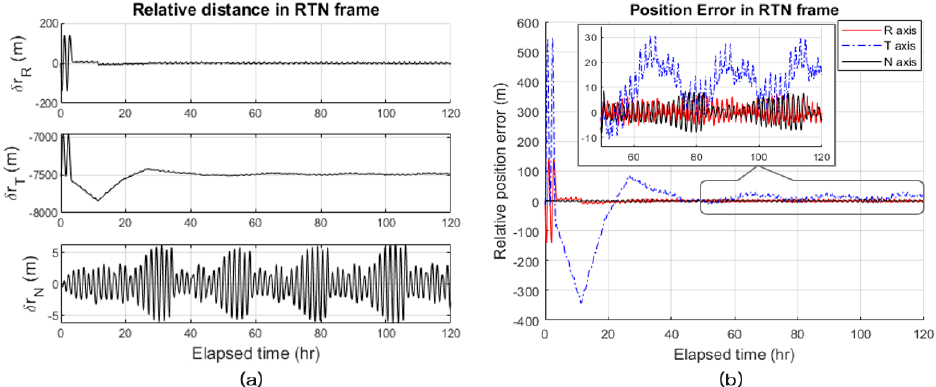
Figure 6. Simulation results of the relative orbit control algorithm. The relative position of the trail deputy satellite ( a ), and the position error with respect to the nominal relative position ( b ) in the RTN frame over elapsed time.